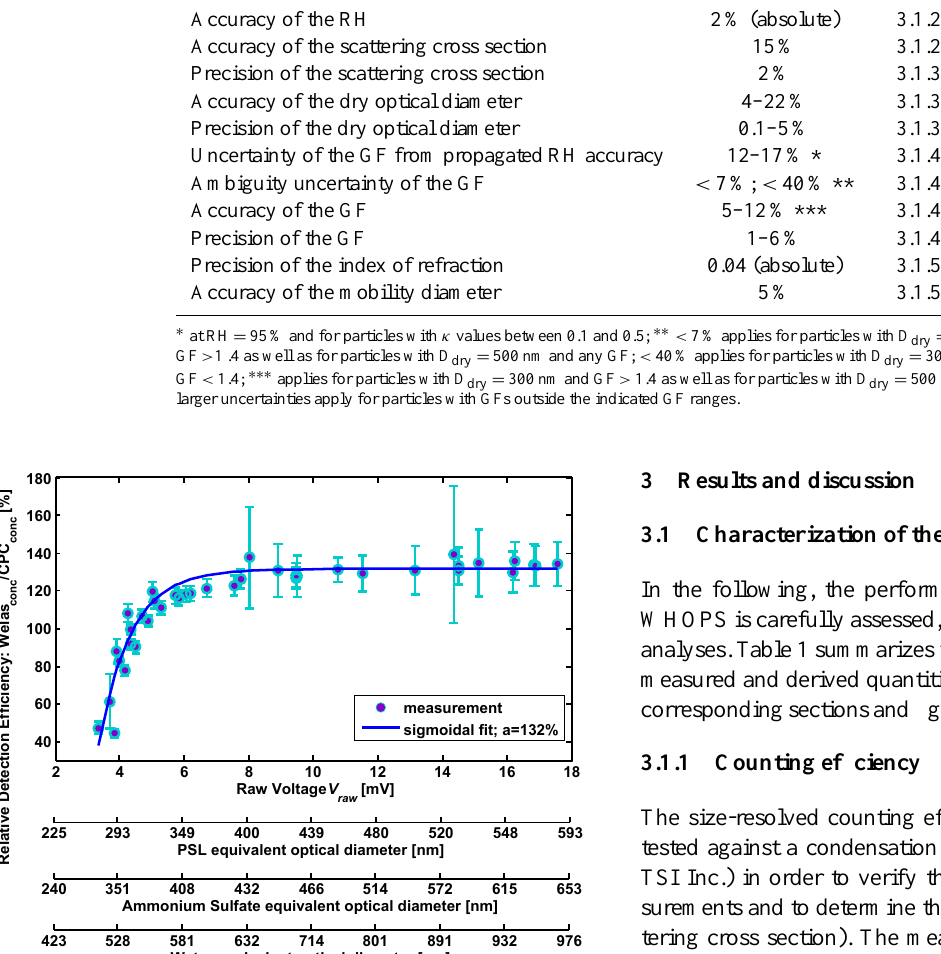
Table 1. List of uncertainties (1 SD) of all relevant measured and derived quantities (given as relative uncertainties if not otherwise stated). The last two columns contain references to more detailed error analysis figures and to the sections containing the detailed discussion. Description Section Figure